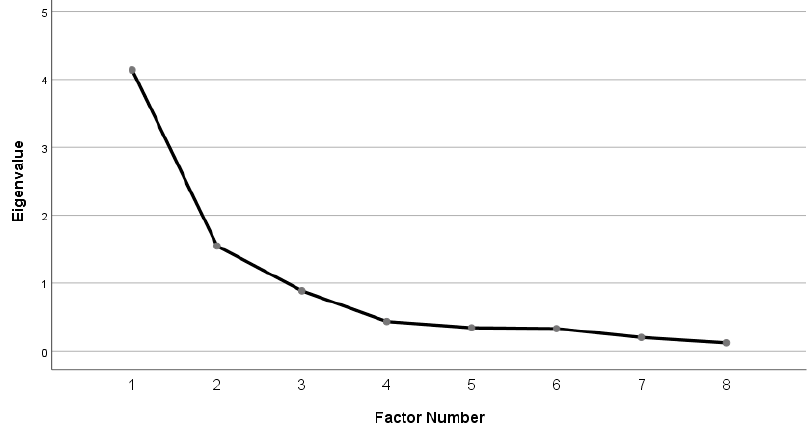
Figure 1. Scree plot for factor components of the Child Vitality-Relaxation Scale. Table 2. Factor analysis and reliability of the Child Vitality-Relaxation Scale.